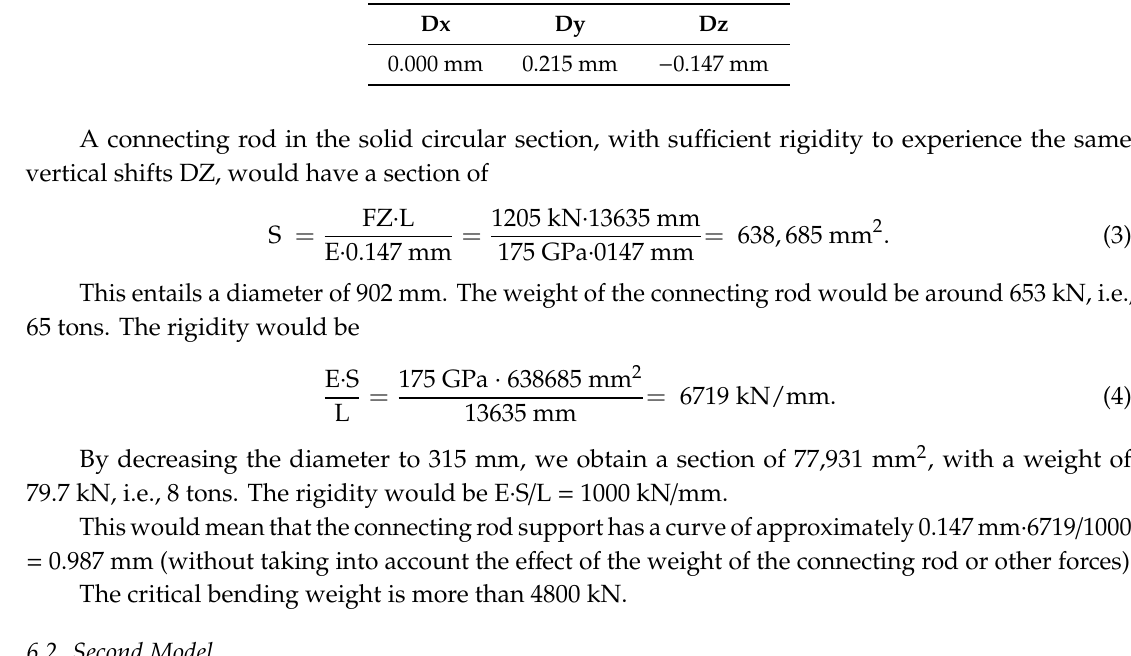
Table 6. Wall displacement in the support area of the